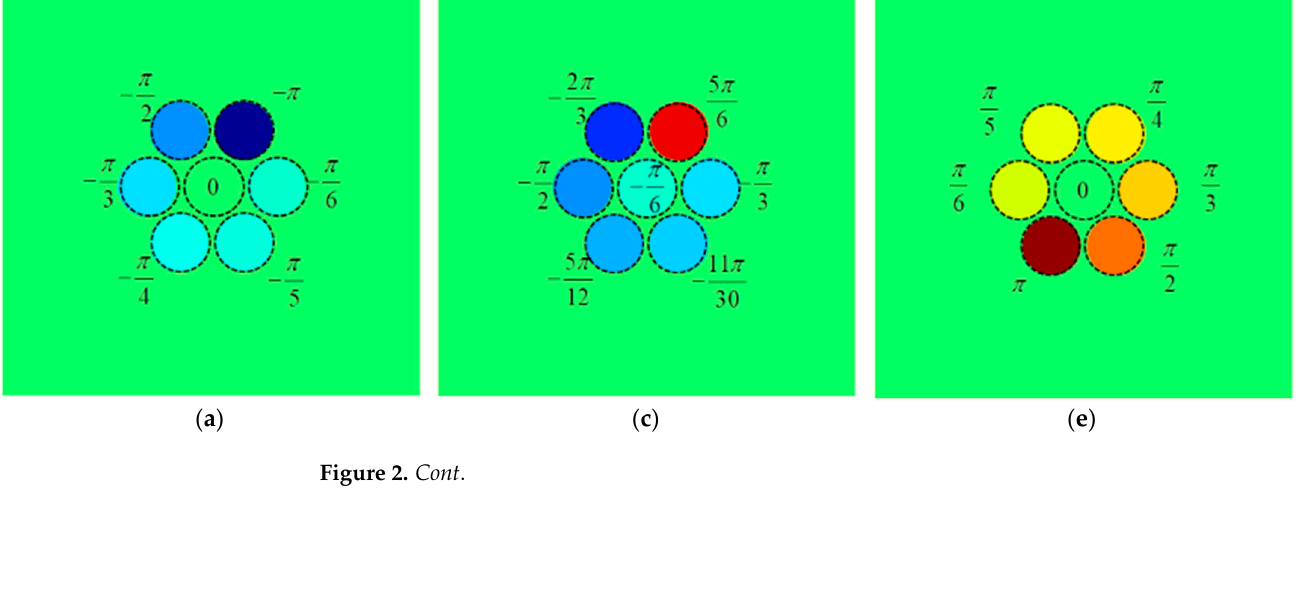
Figure 1. ( a ) The structure of the N-elements CBC system (N = 7 in this diagram); ( b ) Schematic diagram of the emissive plane coordinate system.